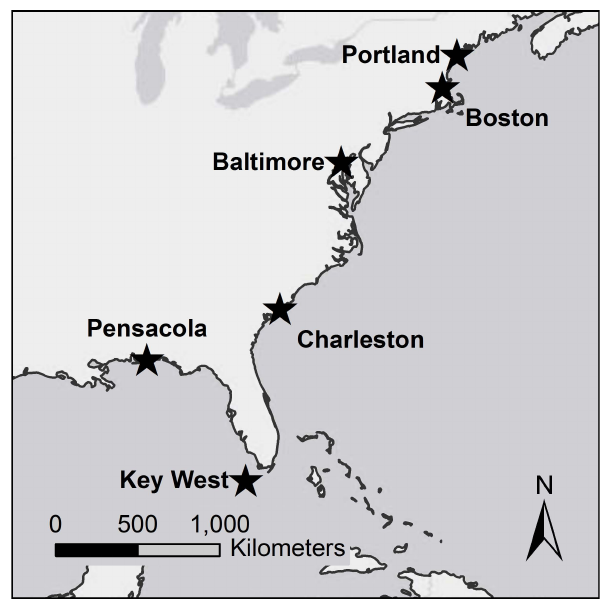
Fig. 5. Map of the six tidal stations.